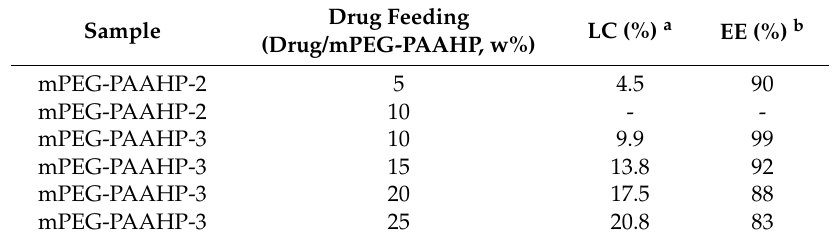
Table 2. PTX loaded into mPEG-PAAHPs based nanoparticles with varying drug feeding Drug Feeding LC (%) a EE (%) b Sample (Drug/mPEG-PAAHP, w%) mPEG-PAAHP-2 5 4.5 90 mPEG-PAAHP-2 10 - - mPEG-PAAHP-3 10 9.9 99 mPEG-PAAHP-3 15 13.8 92 mPEG-PAAHP-3 20 17.5 88 mPEG-PAAHP-3 25 20.8